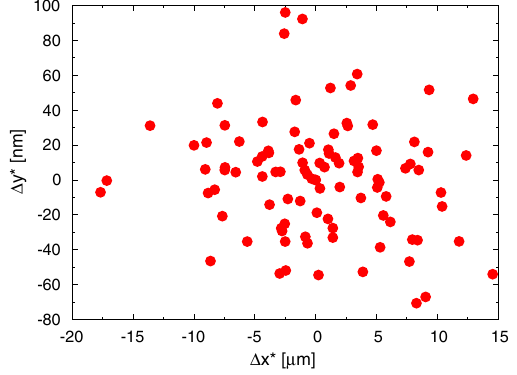
FIG. 3. Relative beam position offsets at the IP.